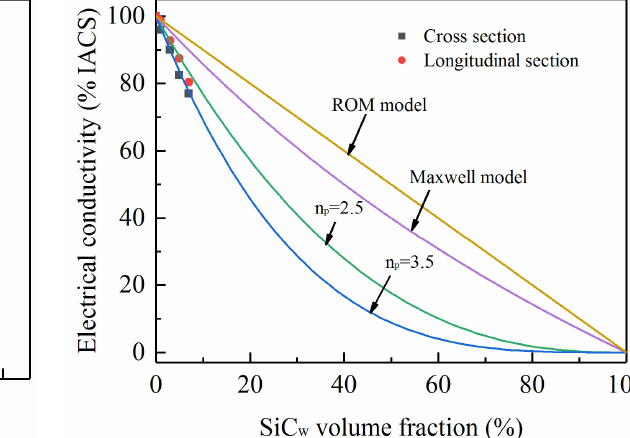
Figure 6: Relationship among electrical conductivity, SiC whiskers spatial distribution and volume fraction in the SiC w /Cu composites